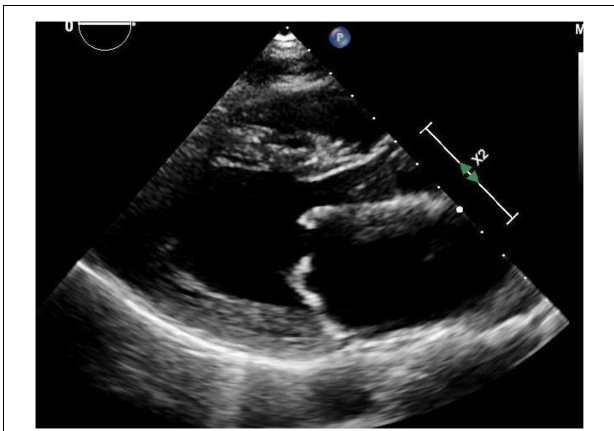
FIGURE 2 | Mitral stenosis: Representative parasternal long axis view during showing mitral stenosis in a woman with rheumatic heart disease. Both leaflets are affected with thickening and also restriction of their